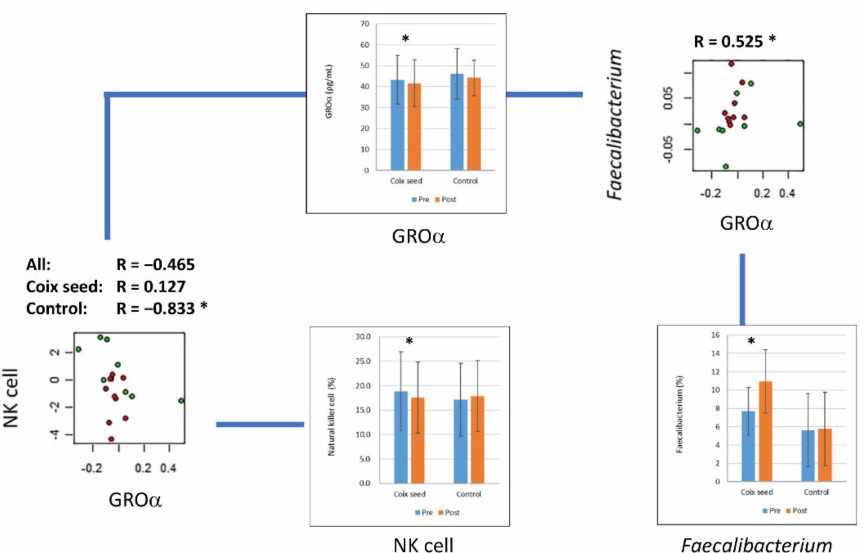
Figure 4. GRO- α and its correlation with the natural killer cell percentage and intestinal abundance of Faecalibacterium prausnitzii . The plasma concentration of GRO- α significantly decreased after coix seed consumption. The change in GRO- α showed a significant correlation with the change in intestinal abundance of F. prausnitzii . The change in GRO- α showed a negative correlation with the change in natural killer (NK) cell percentage; however, the correlation differed between the coix seed consumption group and the control group. In the scatter plots, the red and green circles denote the coix seed consumption group and the control group, respectively. In the bar graphs, the blue and orange bars denote before (pre-intervention) and after (post-intervention) coix seed consumption, respectively. *, p <